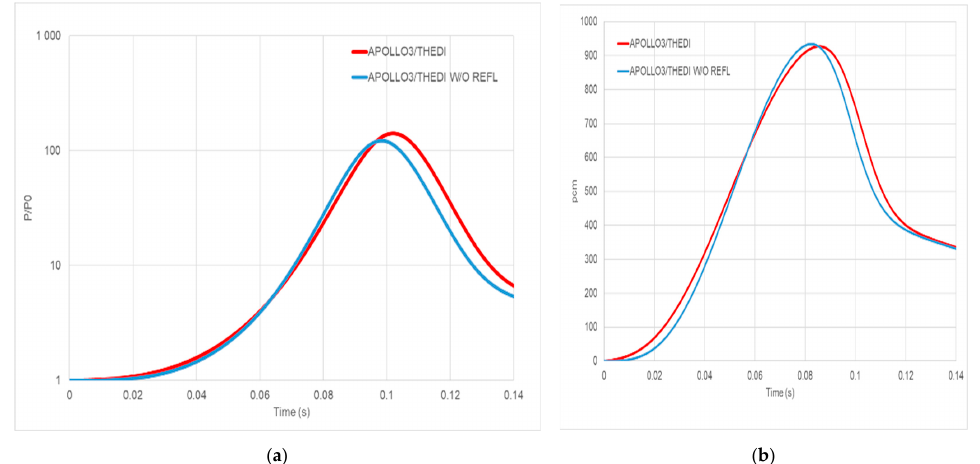
Figure 20. Effect of the configuration on power and reactivity (APOLLO3 ® /THEDI calculations). power ( a ); reactivity ( b ).